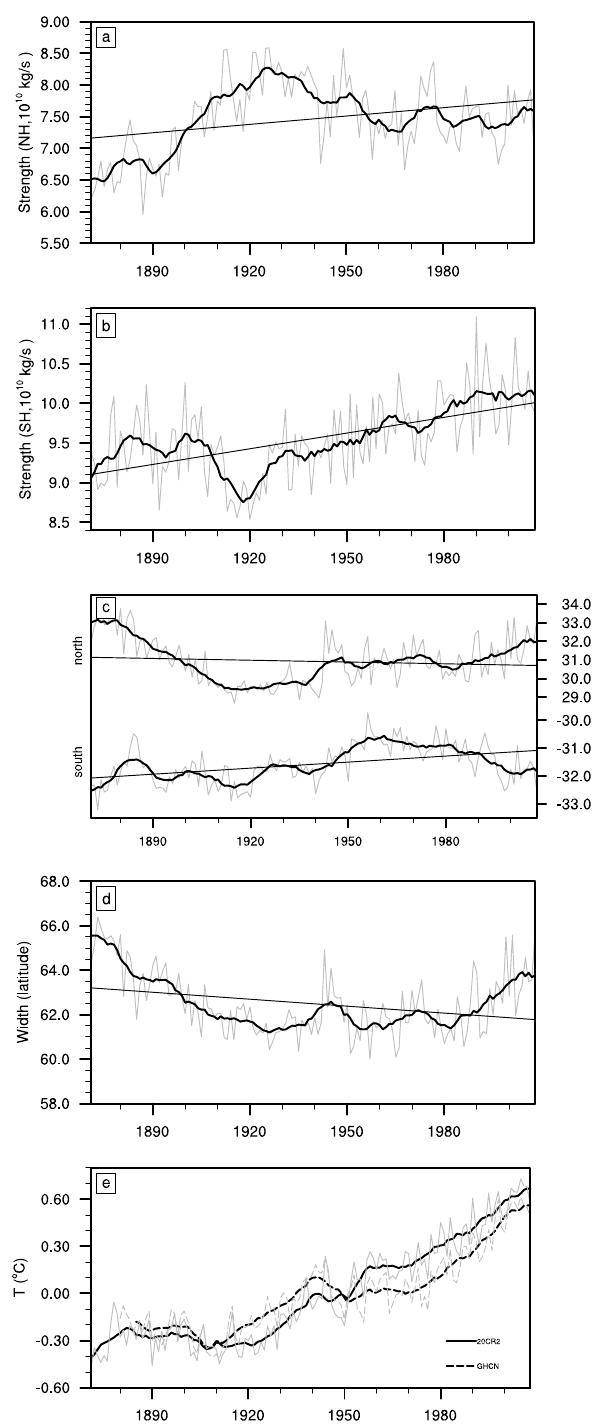
Fig. 2. Time series of the annual-mean (grey line) and 10-yr running mean (black line) strength, edge and width of the Hadley Circula- tion for 1871–2008: (a) the strength of northern component, (b) the strength of the southern component, (c) the poleward-edge of the northern and southern components, and (d) the width and (e) time series of the annual-mean GHCN surface temperature and 20CR2 surface air temperature for 1871–2008.